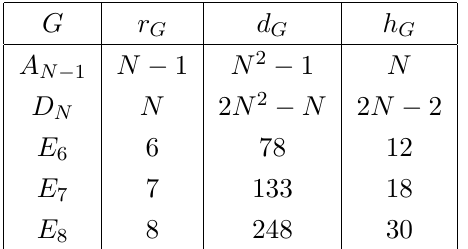
Table 2 . Simply laced Lie Algebras and their rank r G , dimension d G , and Coxeter number h G